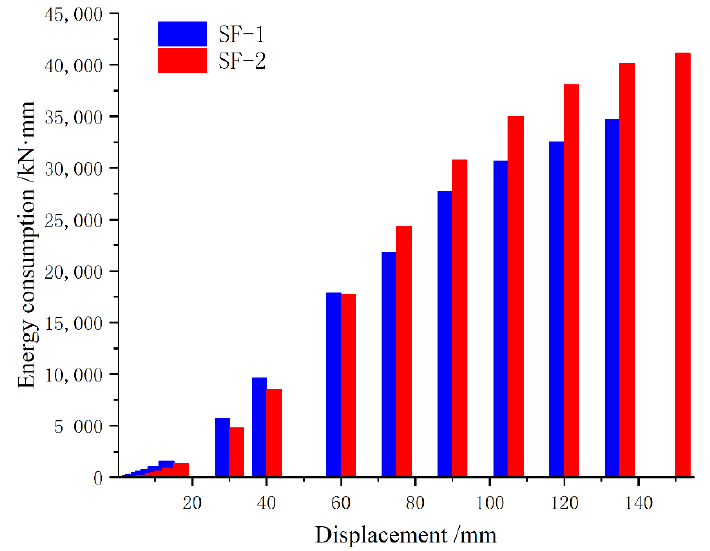
Figure 21. Energy consumption of specimens SF-1 and SF-2 per loading cycle.